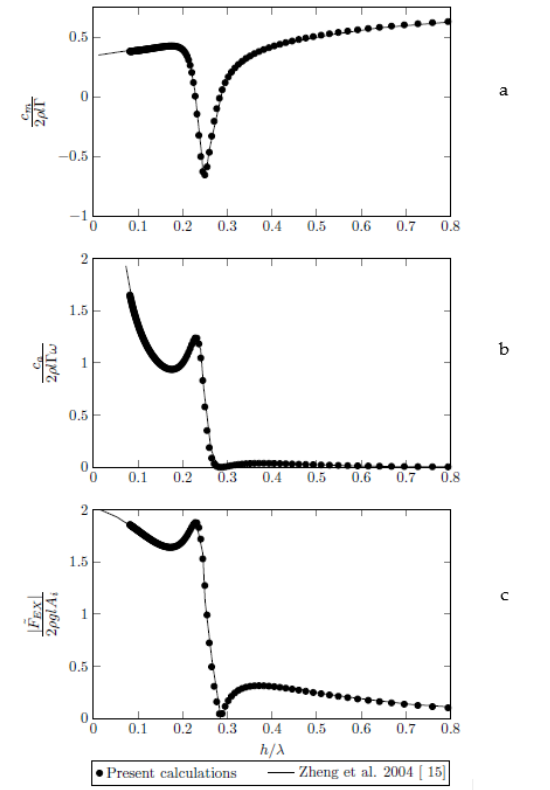
Figure 2. Comparison of hydrodynamic coefficients: ( a ) added mass; ( b ) damping; ( c ) excitation